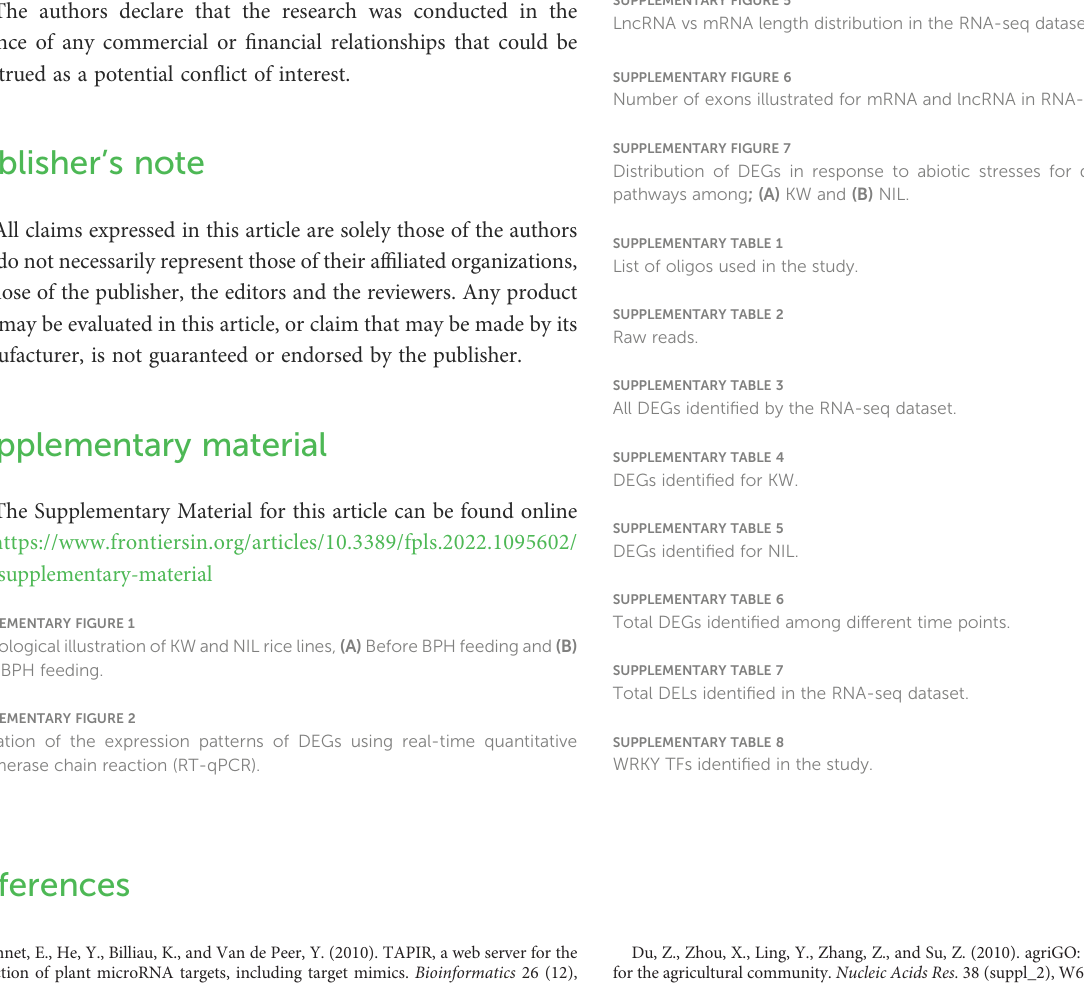
LncRNA vs mRNA length distribution in the RNA-seq dataset.